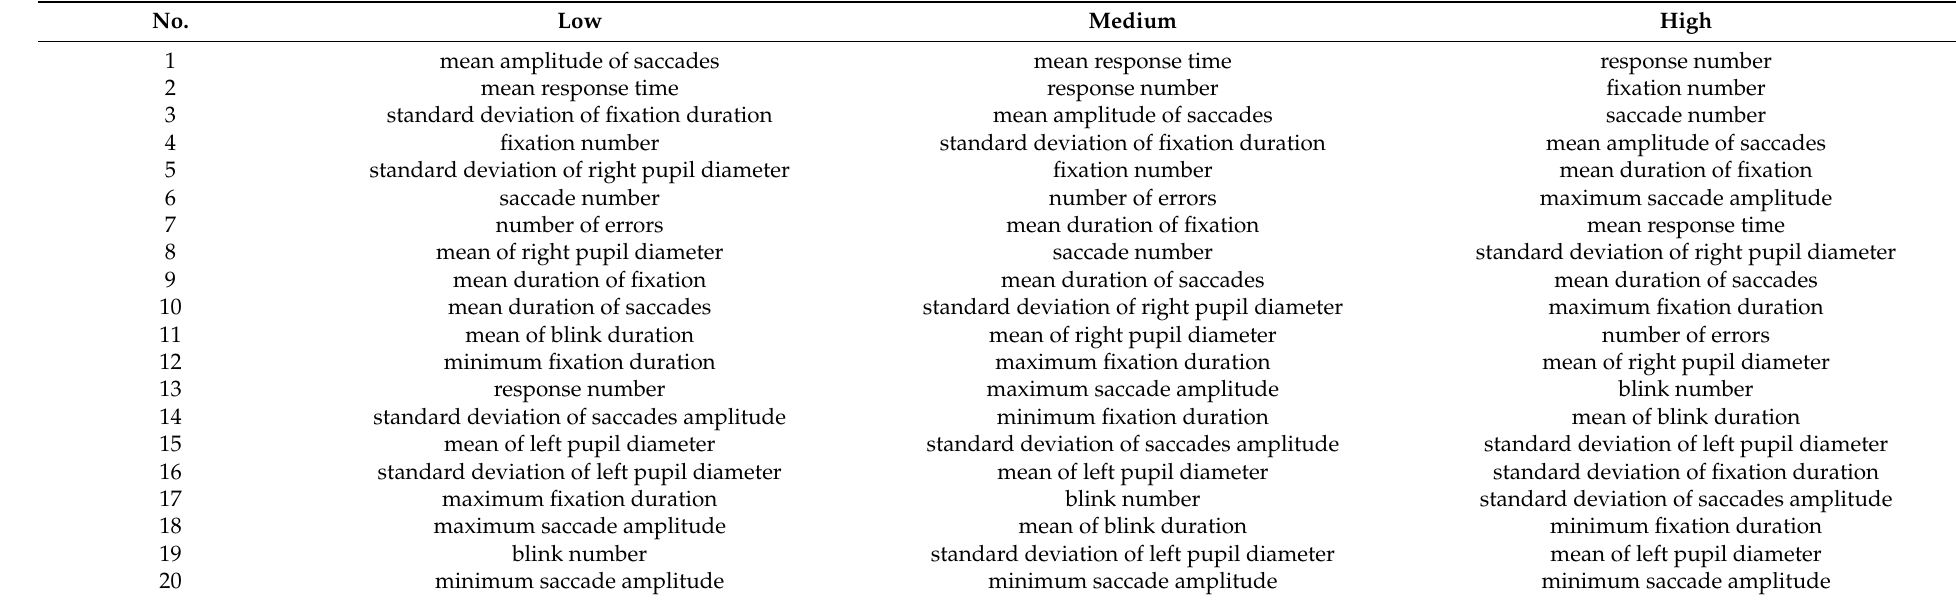
Table 4. Separate class feature rankings obtained by interpreting the weights of the LogReg model with elastic net